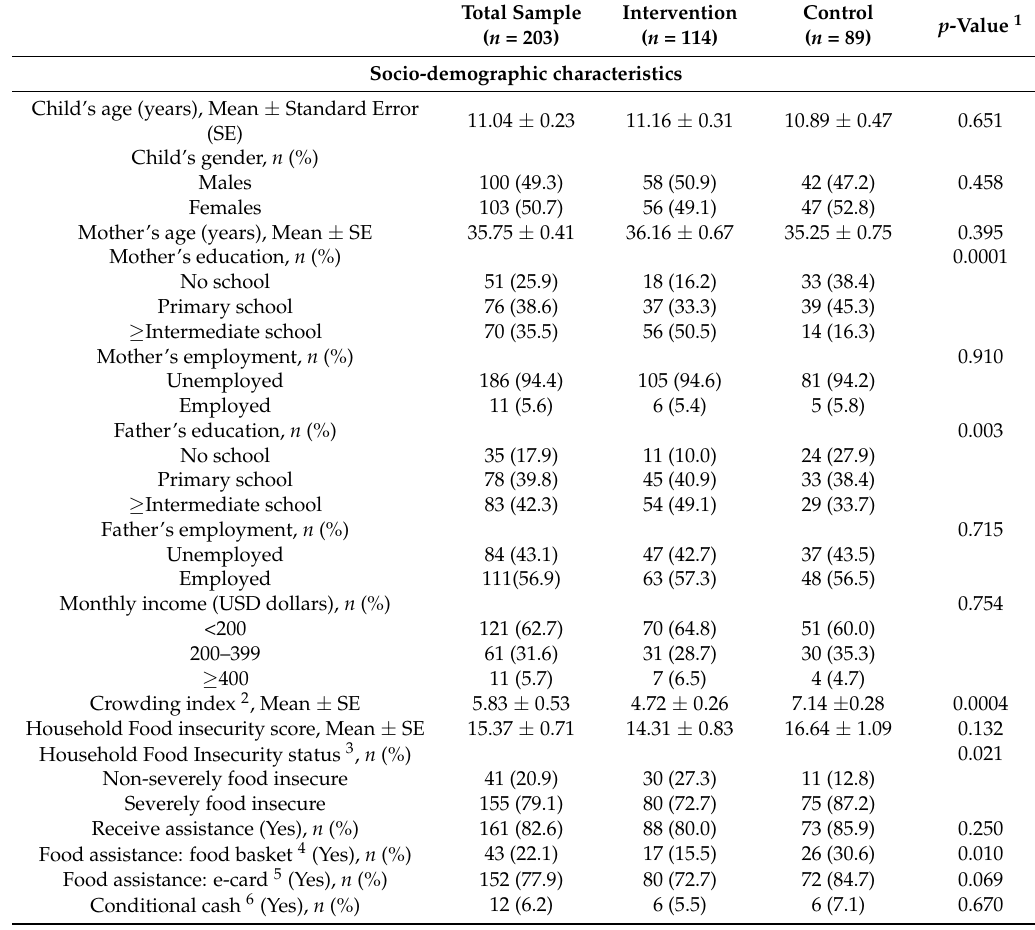
Table 1. Baseline socio-demographic and anthropometric characteristics of school-aged children enrolled in intervention and control elementary schools in the Bekaa region, Lebanon ( n = 203).